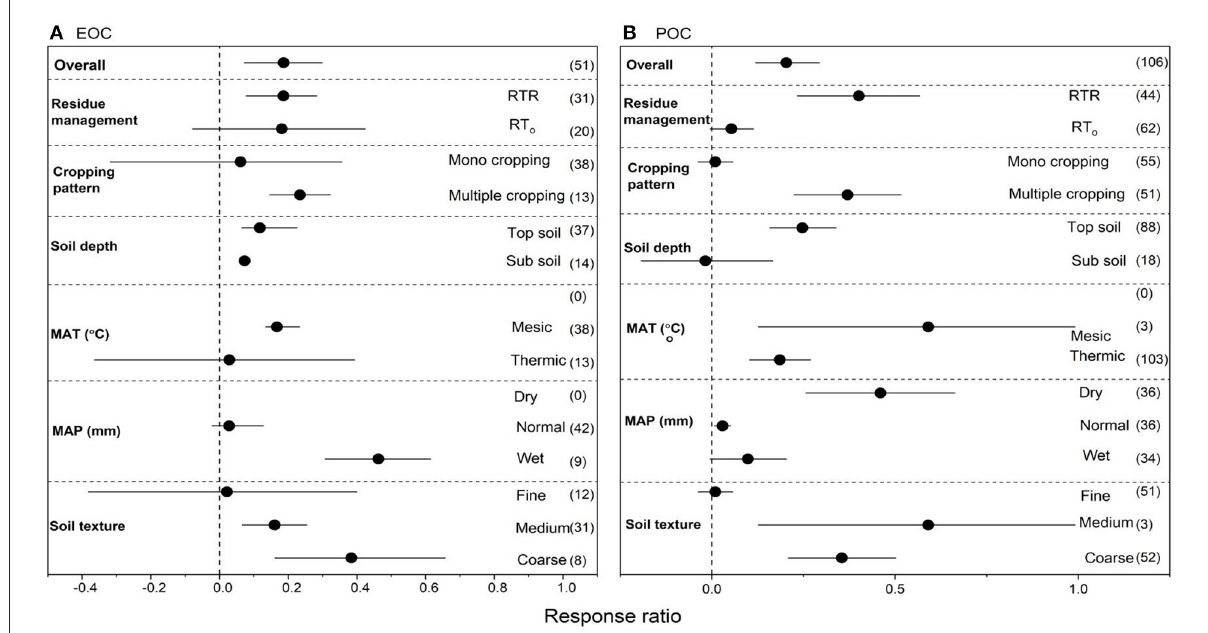
FIGURE7 (A,B) The effect size of easily oxidized organic carbon (EOC) and particulate organic matter (POC) with RT compared to CT. If 95% confidence intervals (CIs) do not overlap with zero, there is a substantial difference in the effect size between treatments. Error bars display CIs. The sample size for each variable is displayed next to each bar. The acronyms stand for mean annual temperature (MAT), mean annual precipitation (MAP), retention of residue (RTR), and no residue retention